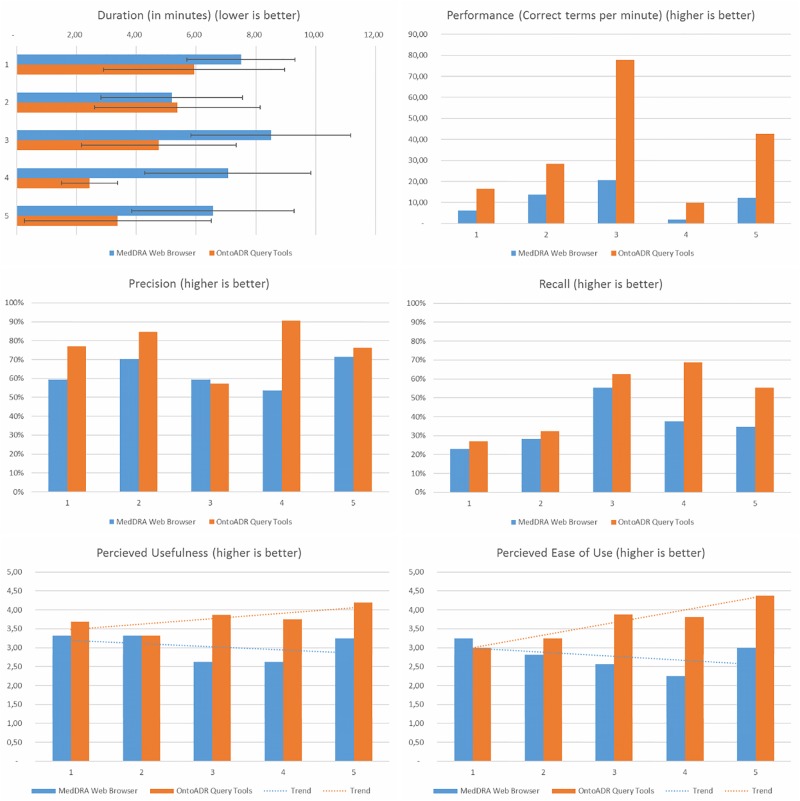
Barcharts showing measures of duration, performance, precision, recall, perceived usefulness, and perceived ease of use for the five safety topics.